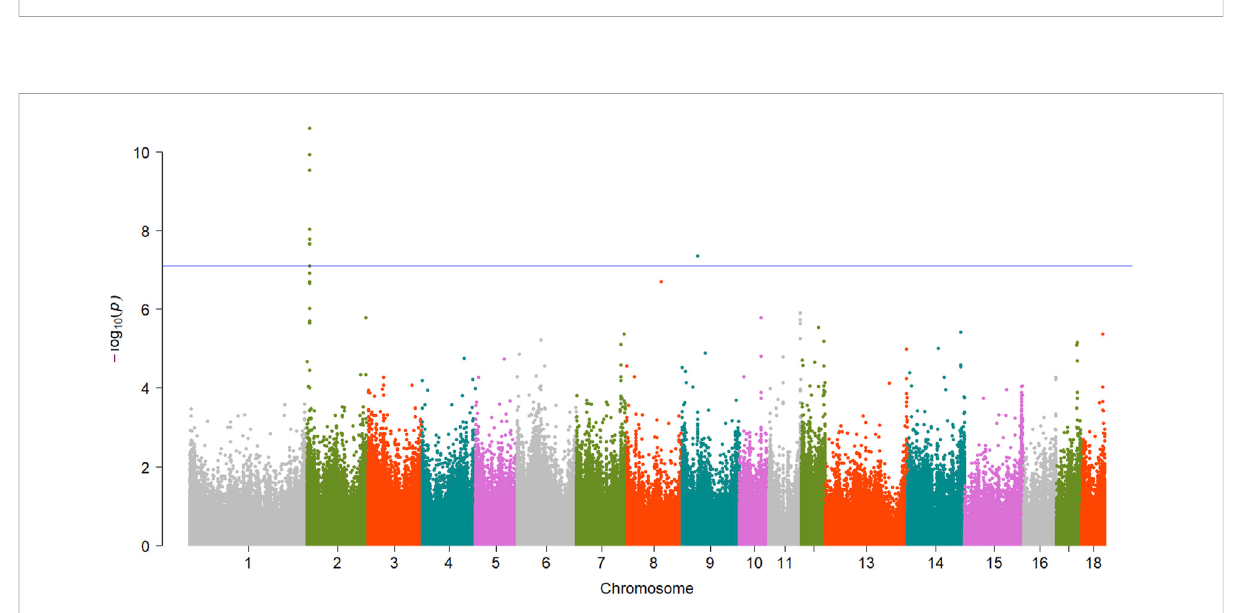
FIGURE 1 The distribution and methylation level of CpG sites for Yorkshire pigs in the 18 autosomal chromosomes. The color of chromosome ideogram represents the methylation level of CpG sites.